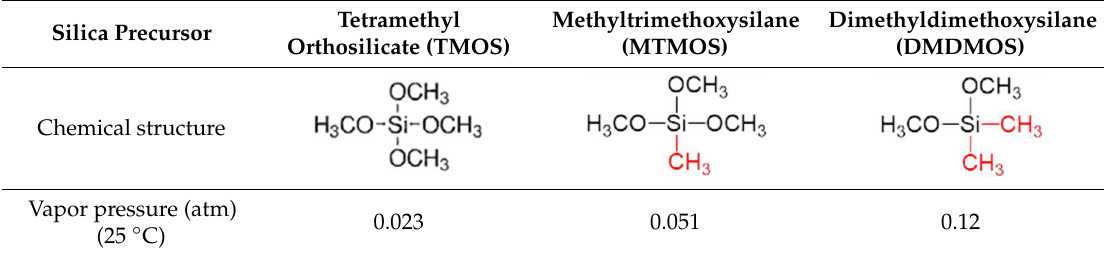
Table 1. Silica precursors and their vapor pressures.